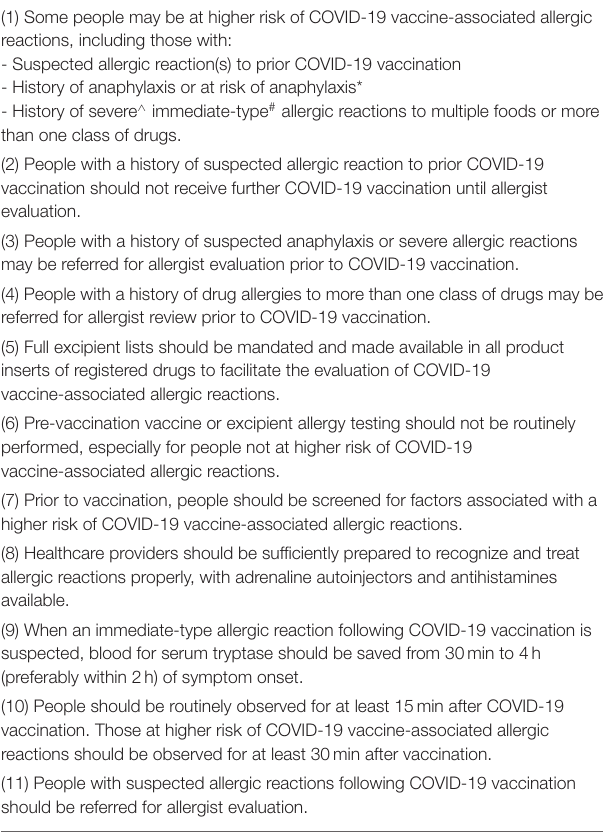
TABLE 3 | Modified ring and messmer grading